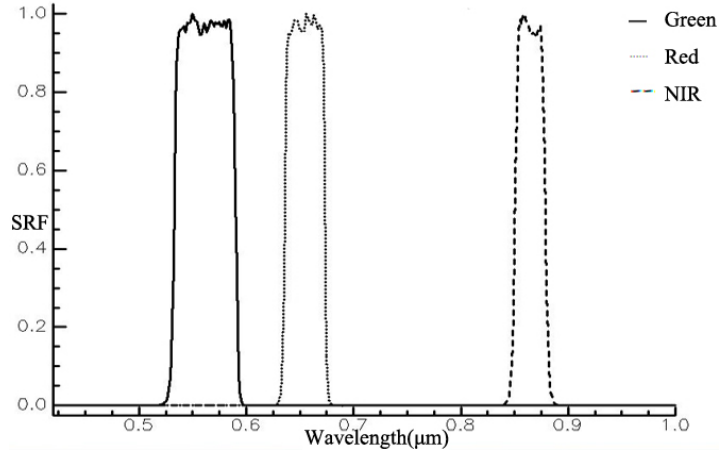
Figure 2. Spectral response function of Landsat-Operational Land Imager (OLI).